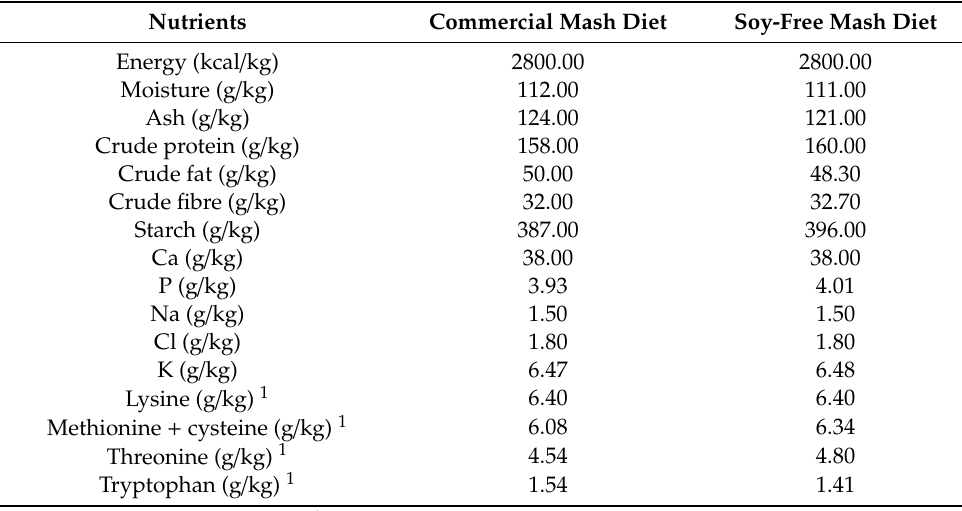
Table 3. Calculated nutrient composition of experimental diets (as in